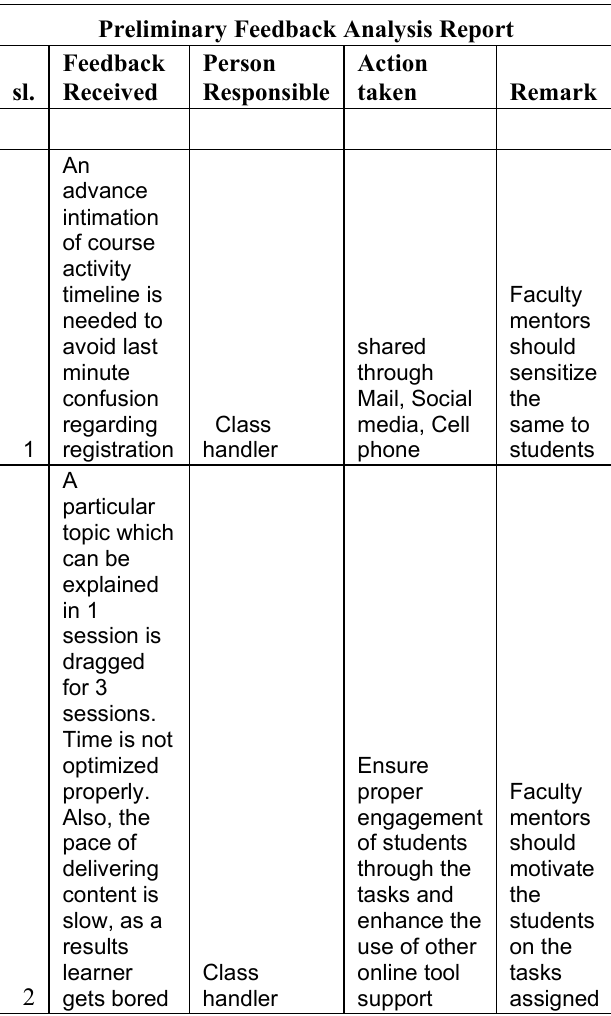
Figure 3. Multicollinearity of student data